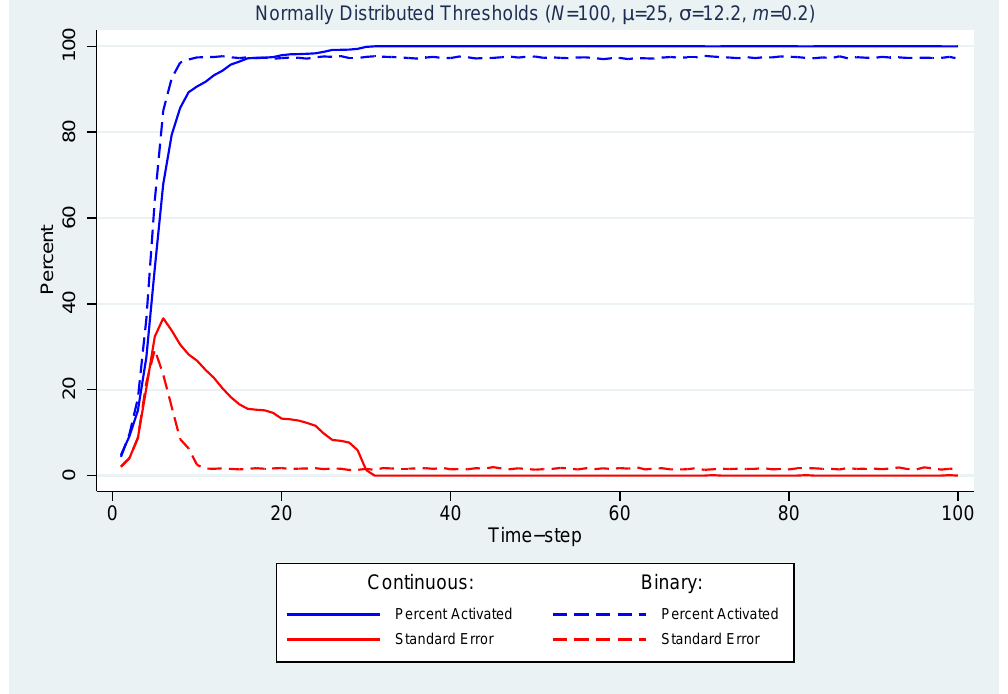
Figure 4: Unpredictability of activation level with continuous and binary stochastic thresholds. Figure 4 is identical to Figure 3 except that the deterministic step function with binary probabilities p = { 0, 1 } is replaced by a stochastic step function with p = { 0.03, 0.97 } . Both functions are stochastic, with identical overall error rates of 0.03, but they differ in whether the probability distributions are continuous (solid line, with m = 0.2) or binary (dashed line). The results show that activation error, not granularity, allows cascades to overcome sampling perturbations. With greater noise (e.g., m = 0.1), the standard error reaches zero more quickly, and with less noise (e.g., m = 0.25), the standard error remains slightly above that for the binary